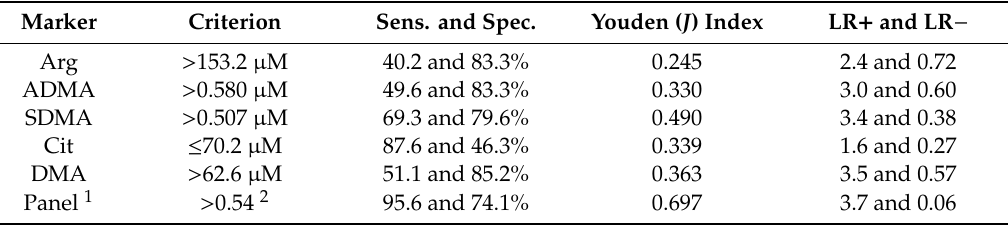
CRC: Colorectal cancer; Sens.: Sensitivity; Spec.: Specificity; LR: Likelihood ratios; Arg: Arginine; ADMA: Asymmetric dimethylarginine; SDMA: Symmetric dimethylarginine; Cit: Citrulline; DMA: Dimethylamine; 1